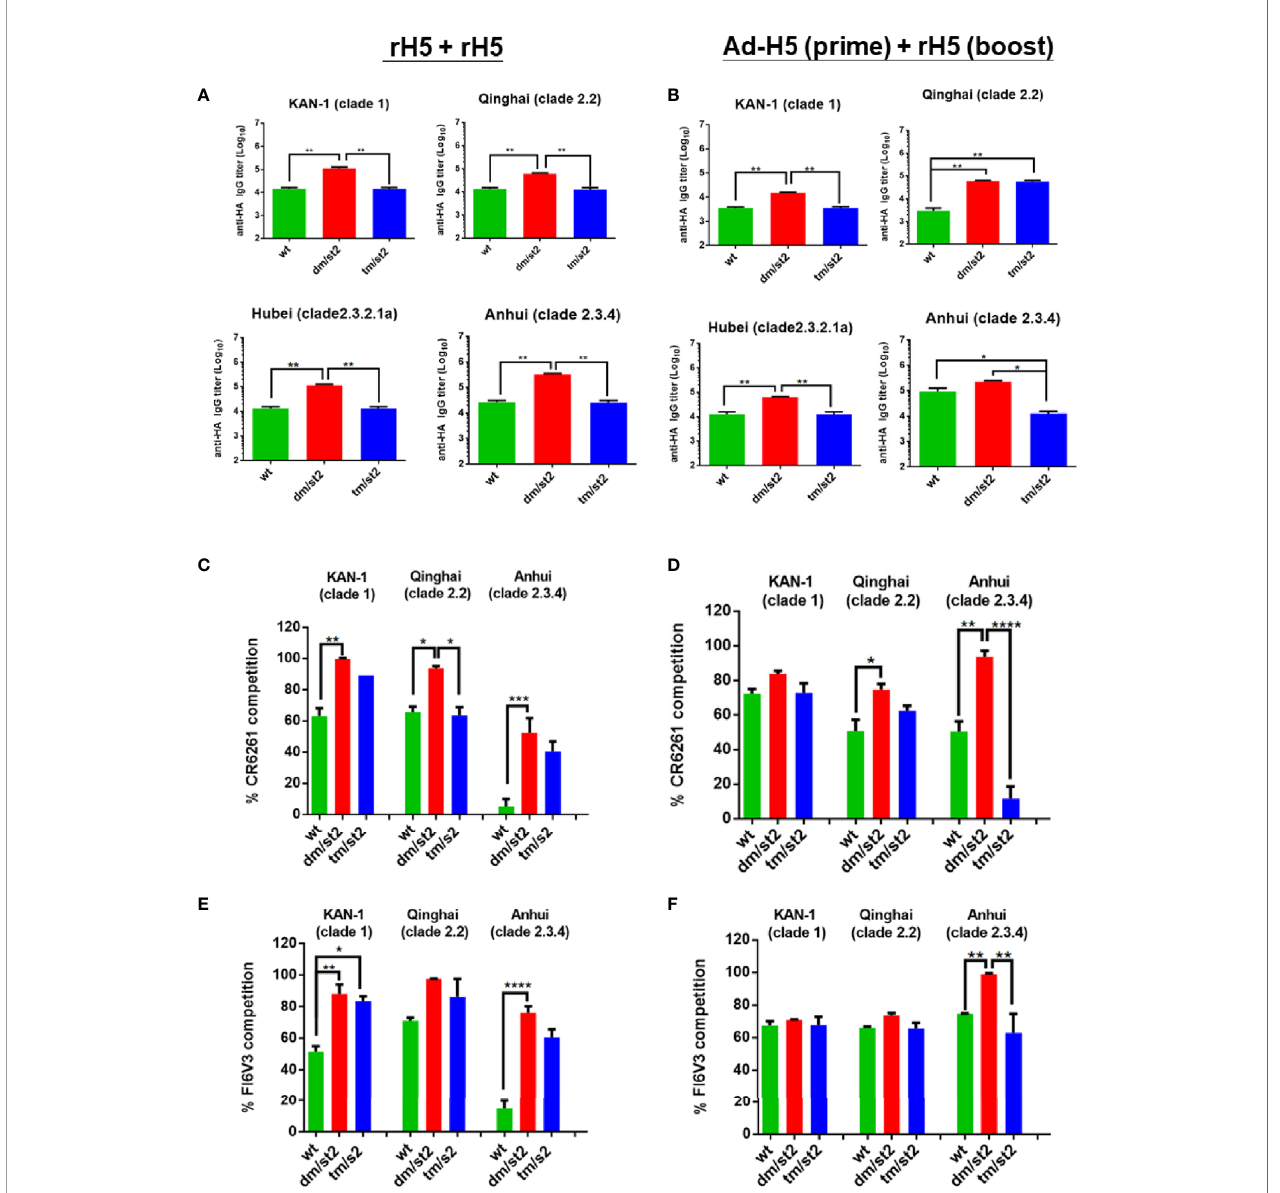
FIGURE 4 | Mapping HA stem-binding antibodies in antisera. Antisera elicited by (A) rH5 + rH5 and (B) Ad-H5 (prime) + rH5 (boost) regimens were absorbed with D stem-rH5 proteins and measured for HA-stem binding IgG titers using ELISA coated with different clade/subclade rH5 proteins. The HA stem-binding antibodies elicited by (C) rH5 + rH5 and (D) Ad-H5 (prime) + rH5 (boost) regimens were measured using mAb CR6261 competition. The HA stem-binding antibodies elicited by (E) rH5 + rH5 and (F) Ad-H5 (prime) + rH5 (boost) regimens were measured using mAb FI6v3 competition. Data were analyzed using one-way ANOVA. (*p < 0.05, **p < 0.01, ***p < 0.001, and ****p <